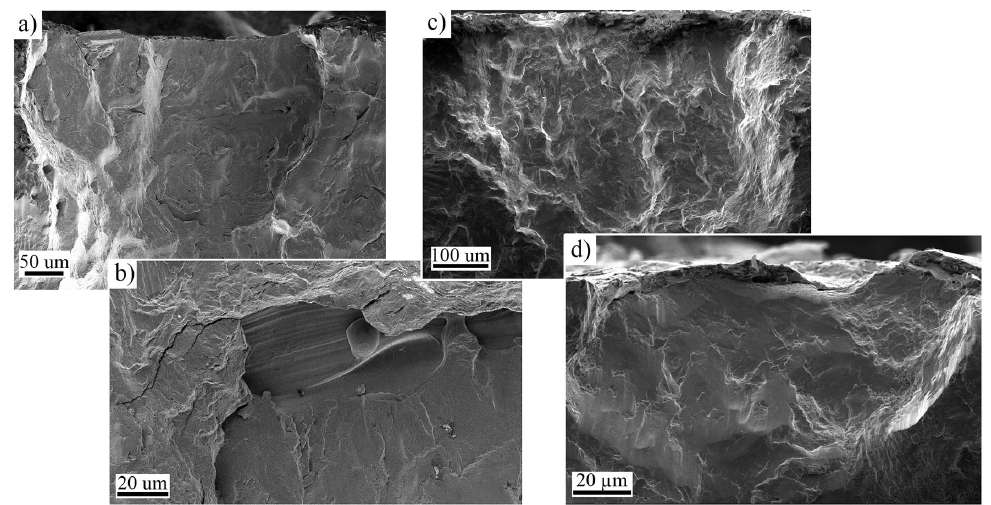
Figure 9. SE-images showing the typical crack initiation sites in fractured samples. For As built and HT sample, fracture initiated either from the ( a ) surface or from ( b ) lack of fusion defects. SSP samples fractured mainly from surface irregularities ( c , d